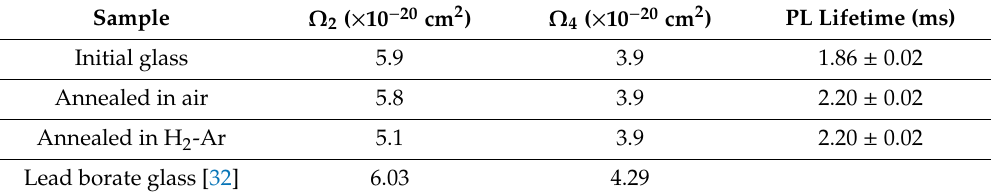
Table 2. The results of the J-O parameter analysis of the Eu-doped chloroborate glass and glass-ceramic annealed at 570 ◦ C in an air and reducing atmosphere (H 2 –Ar); the J-O parameters for